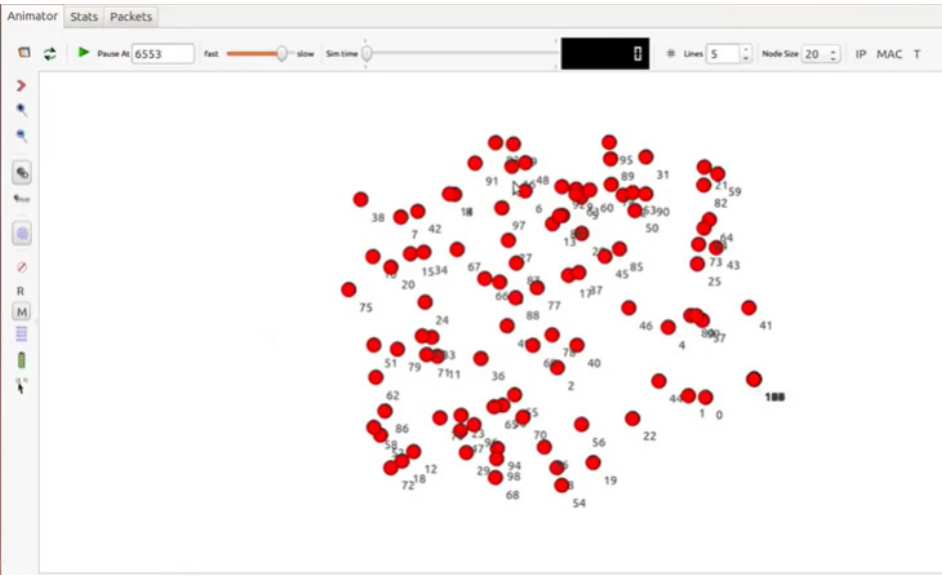
Figure A2. NS ‐ 3.35: Network Scenario (100 Sensor Nodes).